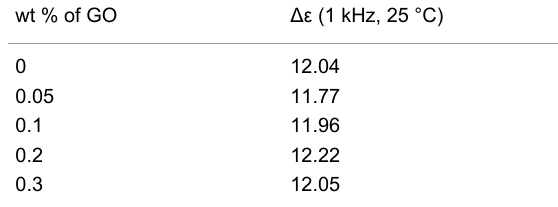
In DS the threshold voltage U th-DS is defined as the point where electric permittivity ε starts increasing from the initial value (perpendicular component of electric permittivity tensor).